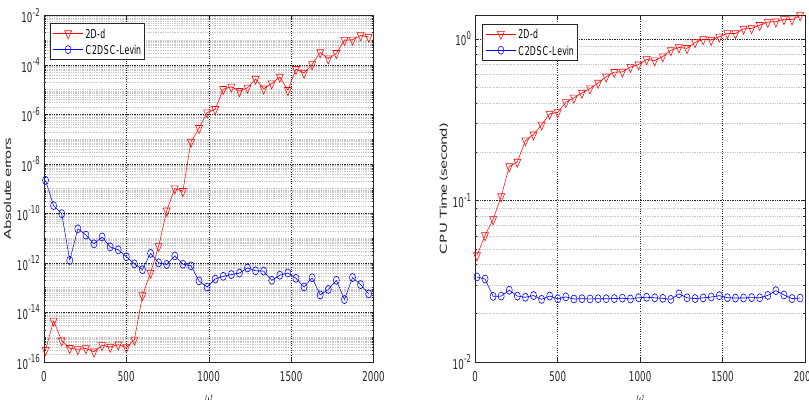
Figure 8. Comparison of 2D-d and C2DSC-Levin in Example 4, ω is a variable (left: absolute errors, right: CPU